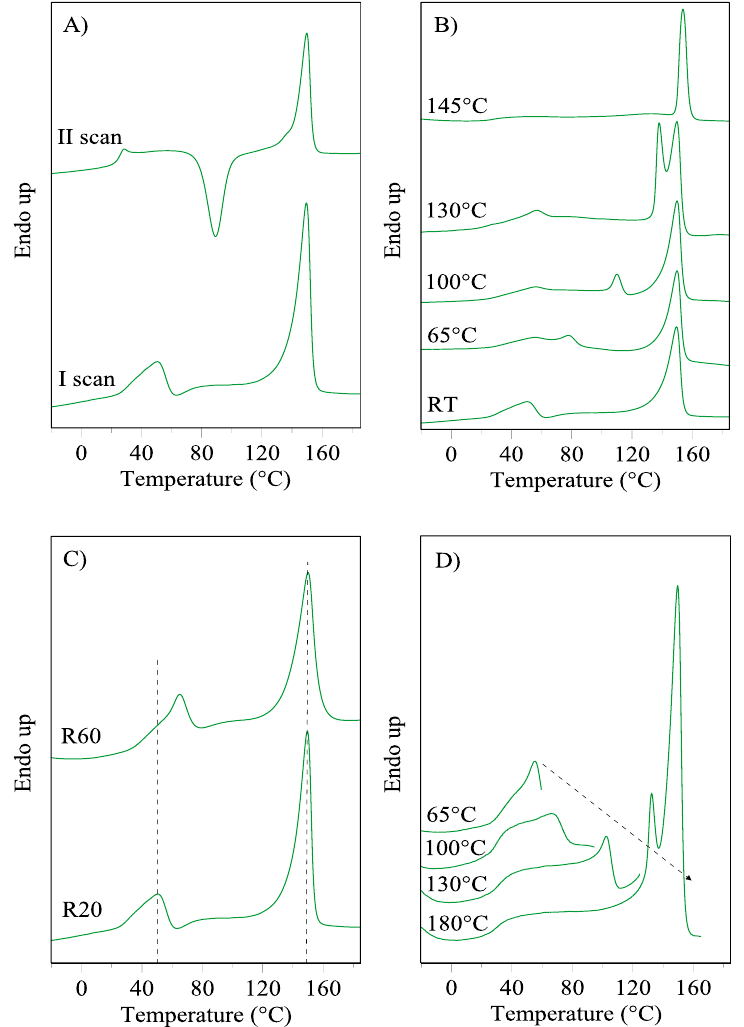
Figure 1. DSC curves of PBTF film: ( A ) I and II scan (20 °C/min); ( B ) untreated and annealed (10 min at the indicated temperatures) film; ( C ) different heating rates (20 and 60 °C/min, dotted lines represent eye guides); ( D ) consecutive heating steps to 65, 100, 130 and 180 °C.